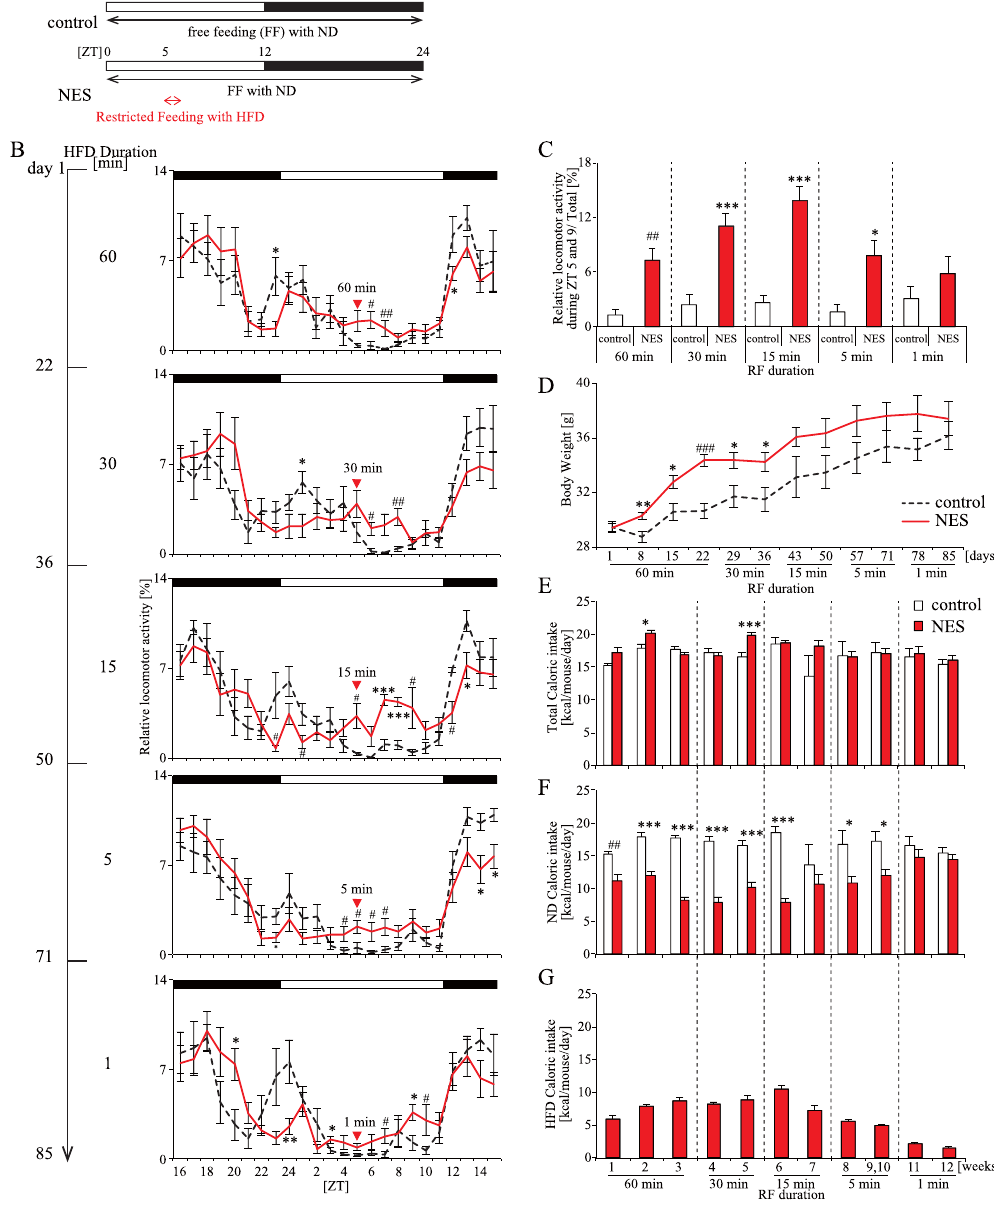
Figure 1. Effect of duration of RF with HFD at ZT 5 on locomotor activity, body weight, and caloric intake (Experiment 1). ( A ) Feeding schedules of the control and NES model groups. Mice in the control group were fed with ND throughout the day. Mice in the NES model groups were fed with ND throughout the day and restricted feeding with HFD at ZT 5. ( B ) Relative locomotor activity rhythm at each time point of RF with HFD at ZT 5 (60, 30, 15, 5, and 1 min). Red triangles represent the start of RF. Open and closed bars indicate light and dark periods, respectively. ( C ) Sum of relative locomotor activity during ZT 5 and 9. ( D ) Increase in body weight. ( E – G ) Change in average caloric intake of total ( E ), ND ( F) , and HFD ( G ) at each RF duration. Data are presented as the mean ± standard error of the mean (SEM; control group, n = 6; NES model group, n = 8). * p < 0.05, ** p < 0.01, *** p < 0.001 vs. the control group (Student’s t -test); # p < 0.05, ## p < 0.01, ### p < 0.001 vs. the control group (Mann-Whitney